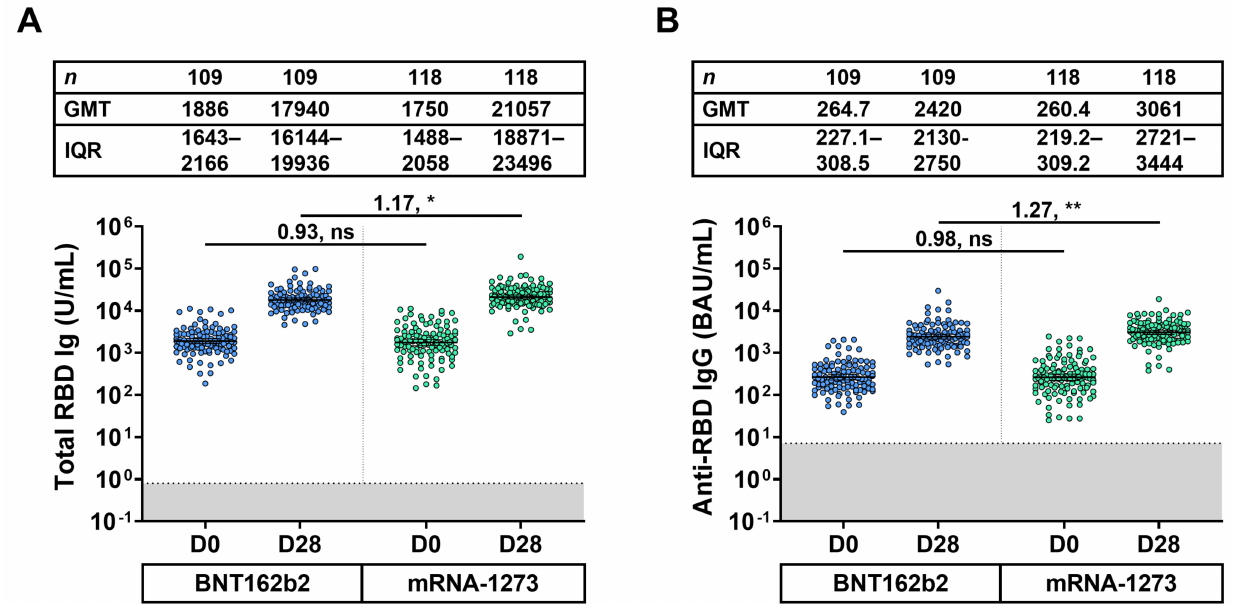
Figure 3. Binding antibody against the receptor binding domain of SARS-CoV-2 of the BNT162b2 and mRNA-1273 booster groups. ( A ) Total immunoglobulin (Ig) specific for the receptor binding domain (RBD) (Total RBD Ig) (U/mL) and ( B ) anti-RBD IgG (BAU/mL) of the BNT162b2 and mRNA-1273 booster groups were monitored at baseline (D0) and 28 days after vaccination (D28). The gray area indicates the seronegativity of total RBD Ig (<0.8 U/mL) or anti-RBG IgG (<7.1 BAU/mL) antibodies. Lines represent the geometric mean titer (GMT) with 95% confidence intervals (95% CI). A pairwise comparison shows geometric mean ratio (GMR) and statistical significance set at p < 0.05 (*), p < 0.001 (**), and no statistical significance